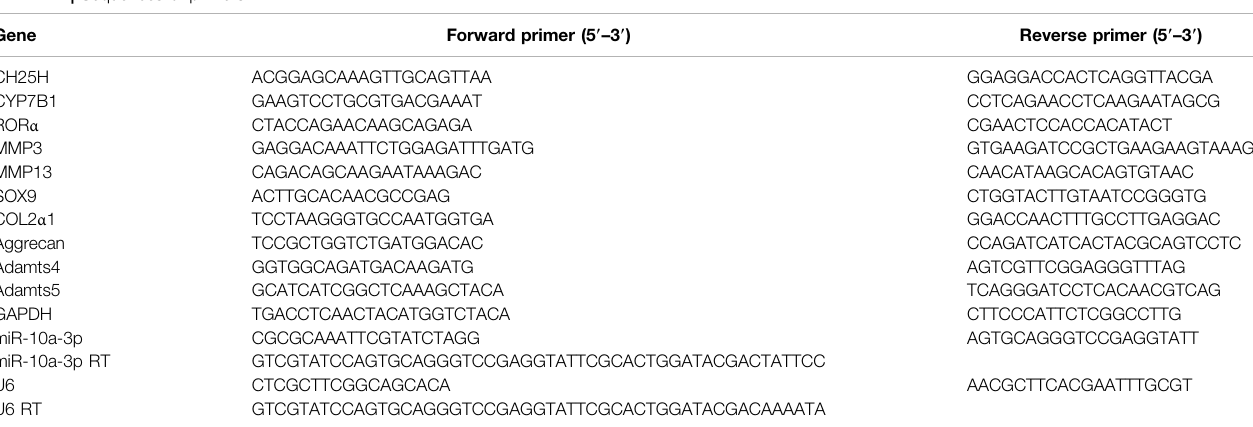
TABLE 1 | Sequences of